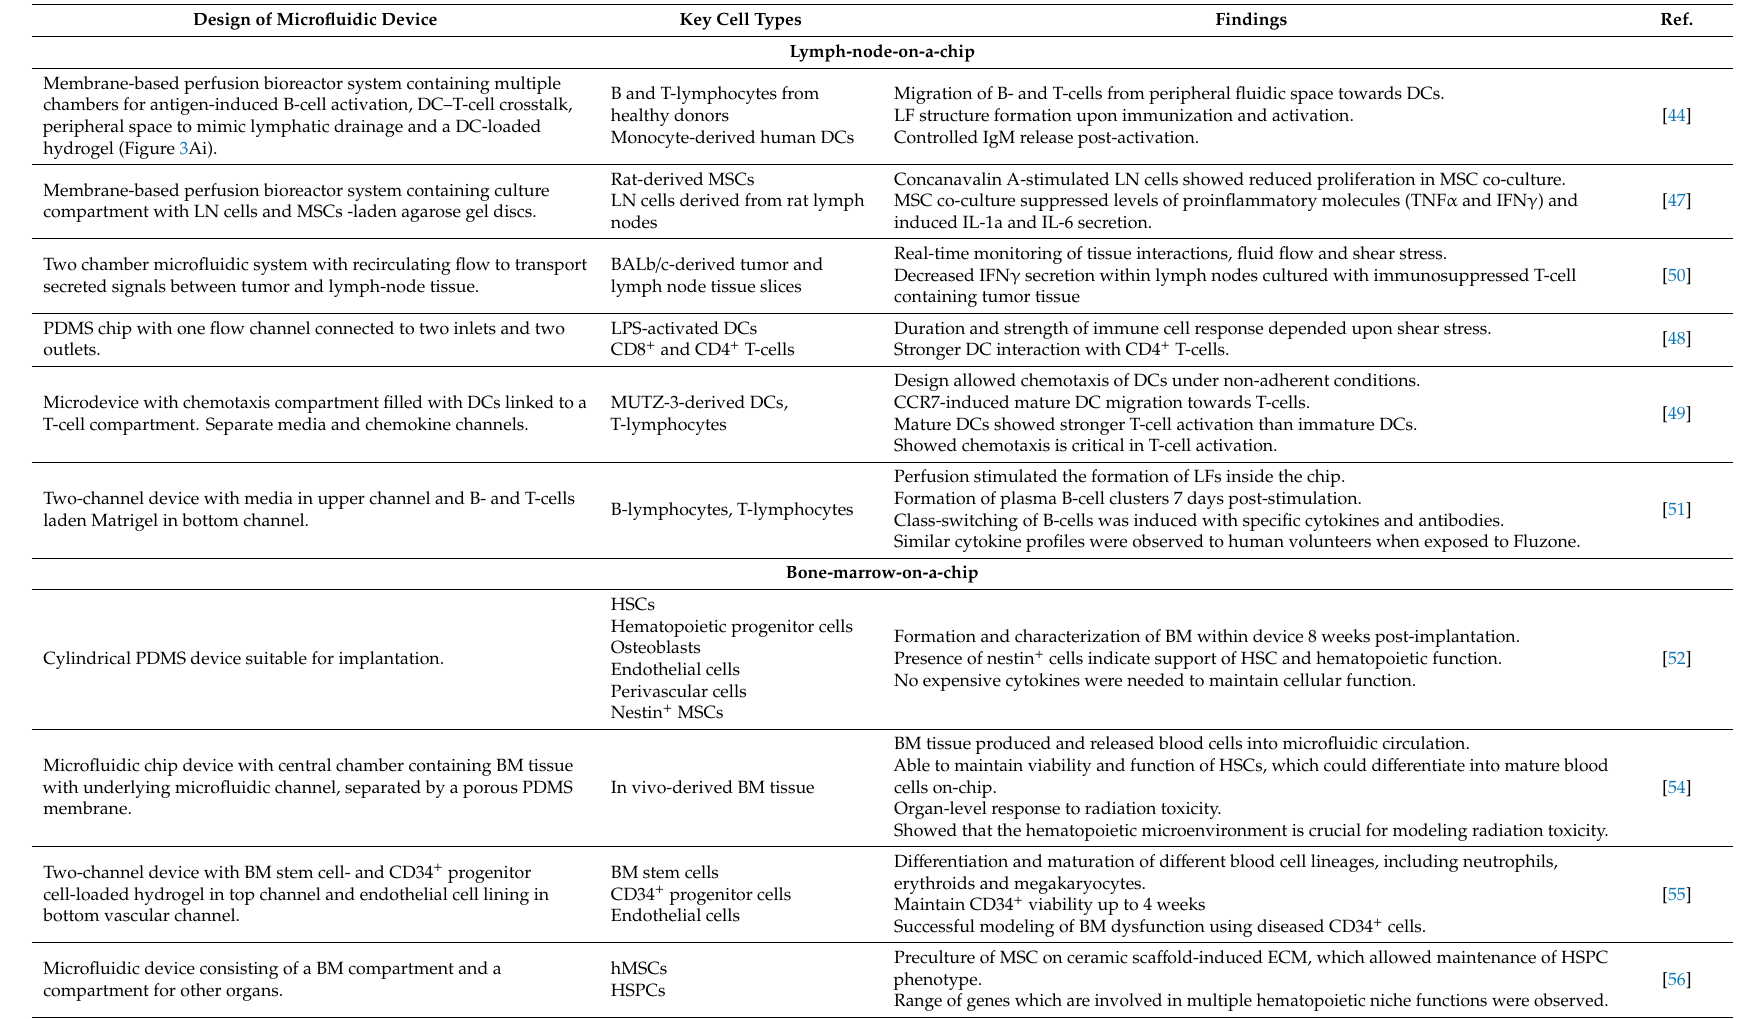
Table 1. Engineering tumor immune